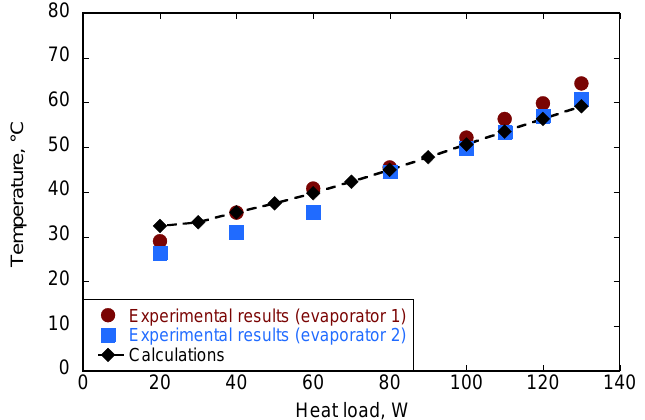
Figure 4. Calculations and experiment results of the two-evaporators type LHP’s each evaporator case’s temperature according to the reference [48] (wick material: stainless steel 316L, working fluid: ammonia).